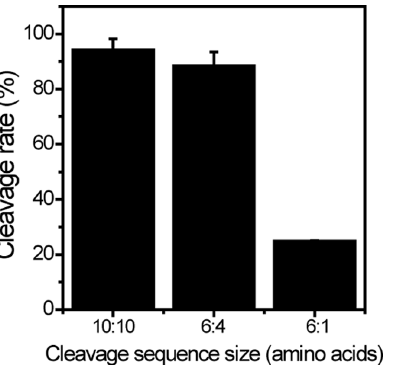
Figure 4. Cleavage sequence length-dependent cleavage efficiency of MBR protein. The cleavage sequence length examined were 20 (10 amino acids-cleavage site-10 amino acids), 10 (6 amino acids-cleavage site-4 amino acids), and 7 (6 amino acid-cleavage site-1 amino acid). Cleavage efficiency was measured using type I MBR and the data was plotted. Experiments were performed at least three times and the data is presented as mean 6 standard deviation (SD).